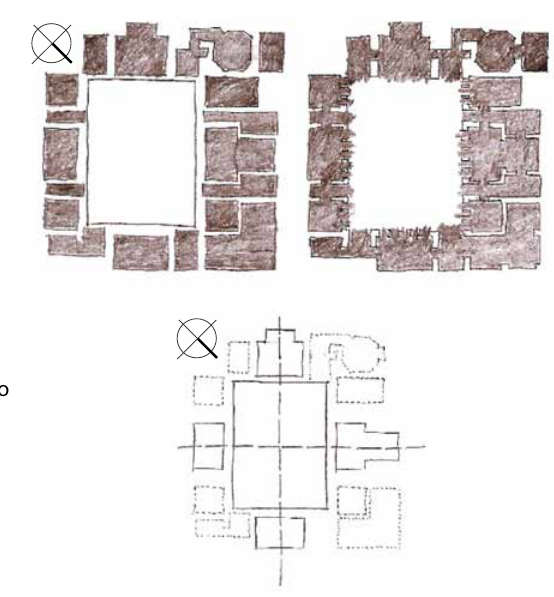
final structure has an ordered and integrated